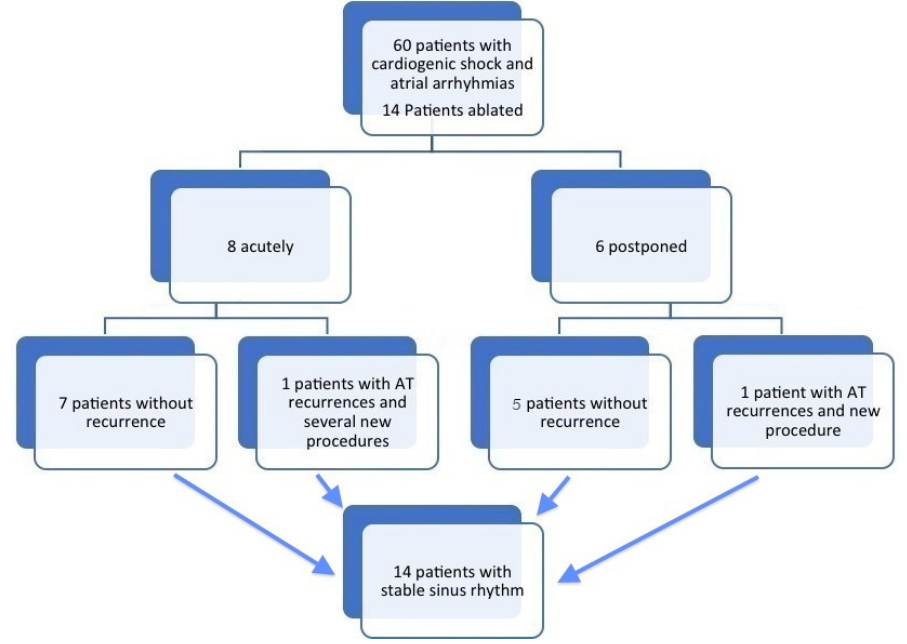
Figure 1. Flow-chart of the included patients. Table 1. Baseline clinical characteristics of included patients.